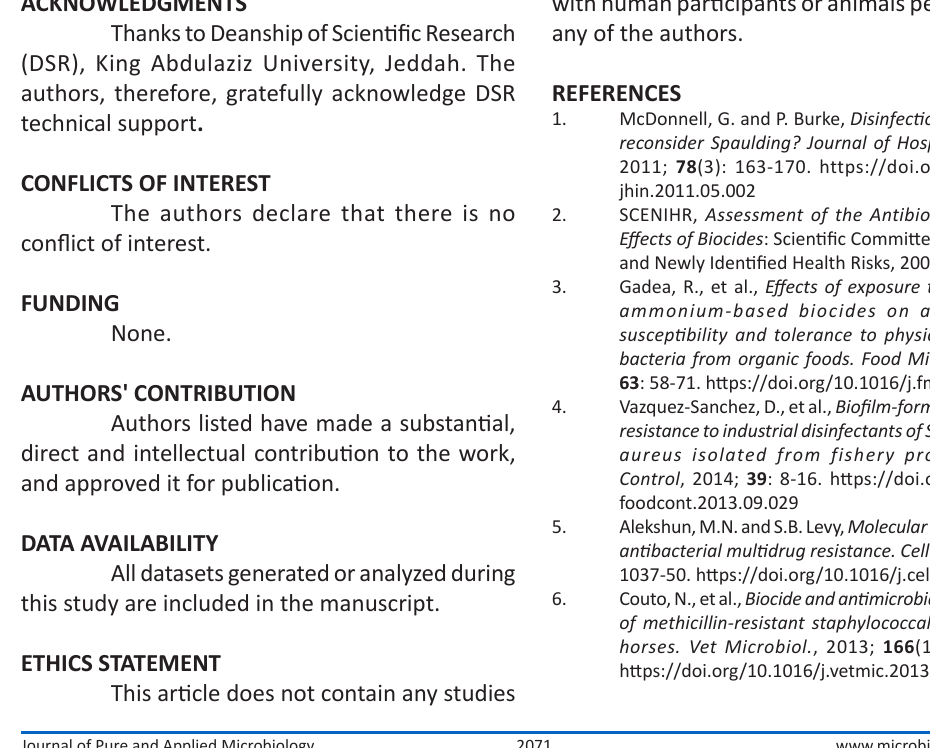
Fig. 8. M. caseolyticus MBC, (a) Sodium hypochlorite #3 = 5000 µg/ml, (b) Benzalkonium chloride #3 = 34.7µg/ml and(c) Chloroxylenol #2 = 150